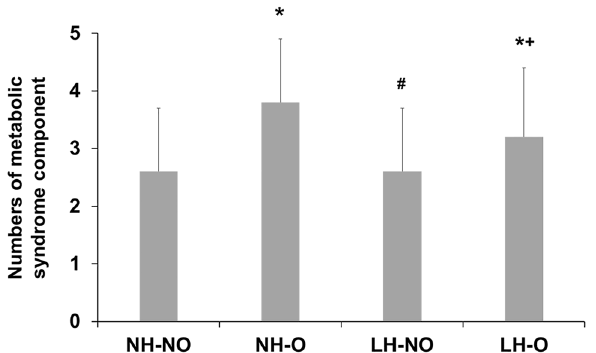
Figure 1. Numbers of metabolic syndrome components according to groups. NH-NO vs NH-O or LH-O, P < 0.05; NH-O vs LH-NO, P < 0.05; LH-NO vs LH-O, P = 0.061; Other comparisons, P > 0.100. * P < 0.05